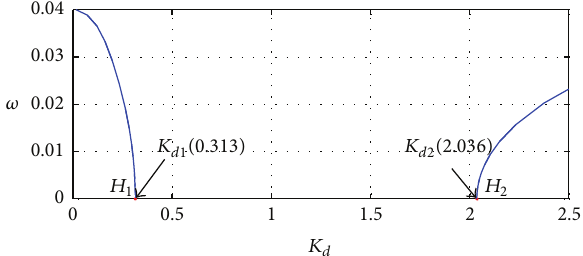
Figure 4: Bifurcation diagram of rotor speed 𝜔